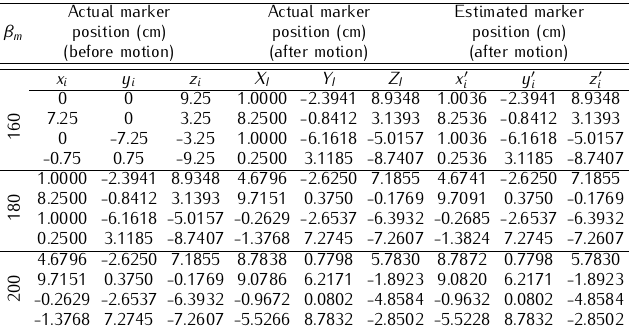
Table 11. Estimated Markers Coordinates after Combined Motion. Table 12. Comaprisons of estimated and actual motion